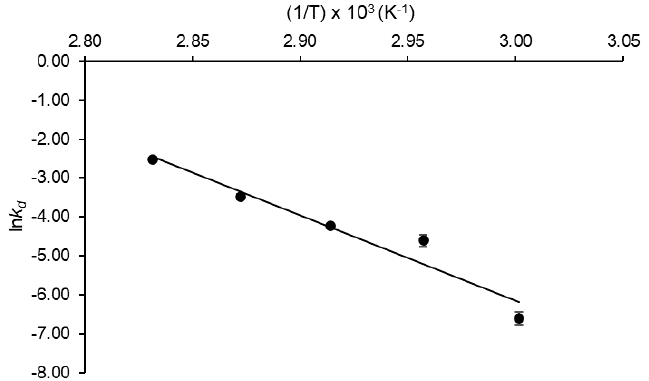
Figure 5. Arrhenius-type plot used to estimate the activation energy of Aspergillus terreus URM4658 inulinase thermal denaturation.